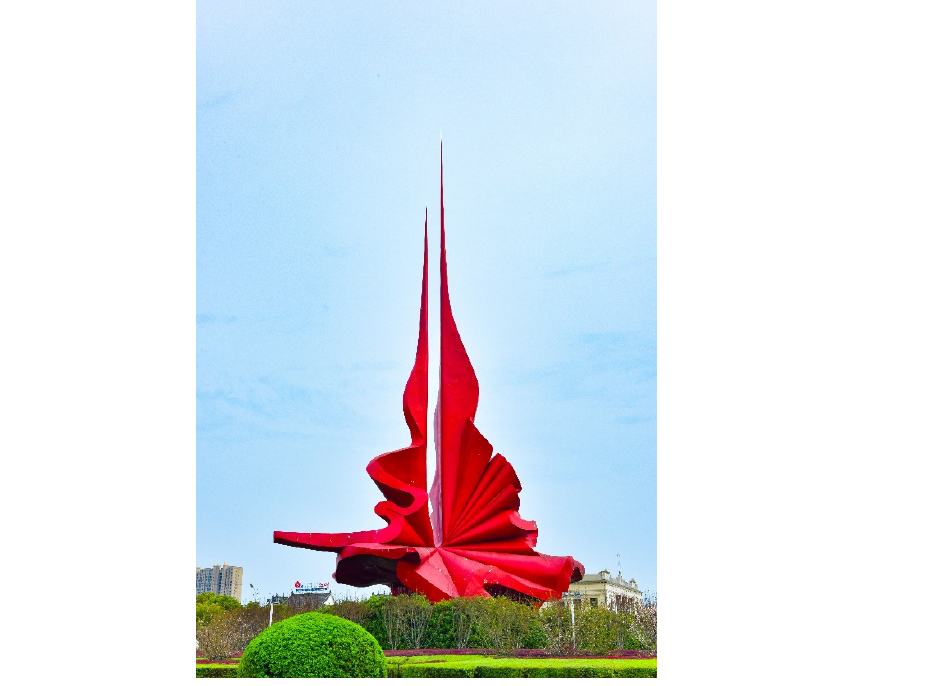
Figure 3. Public artwork “Rubber Duck”.